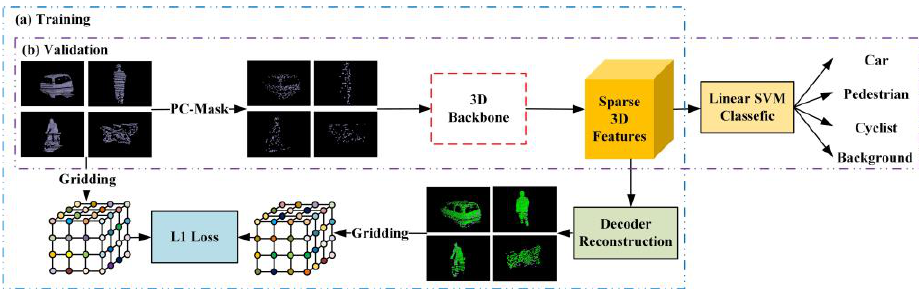
Figure 6. Pre-training flow. ( a ) Training phase. ( b ) Validation phase.